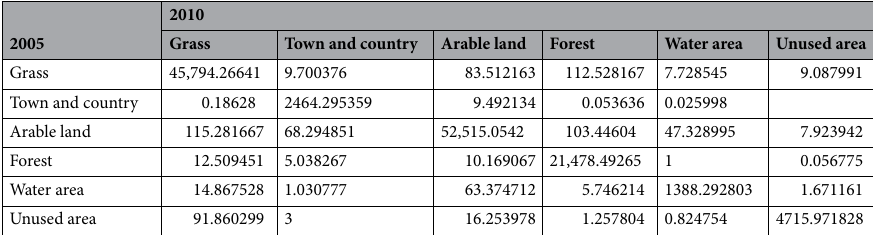
Table 6. Transfer matrix of land use types in the study area from 2005 to 2010 (km 2